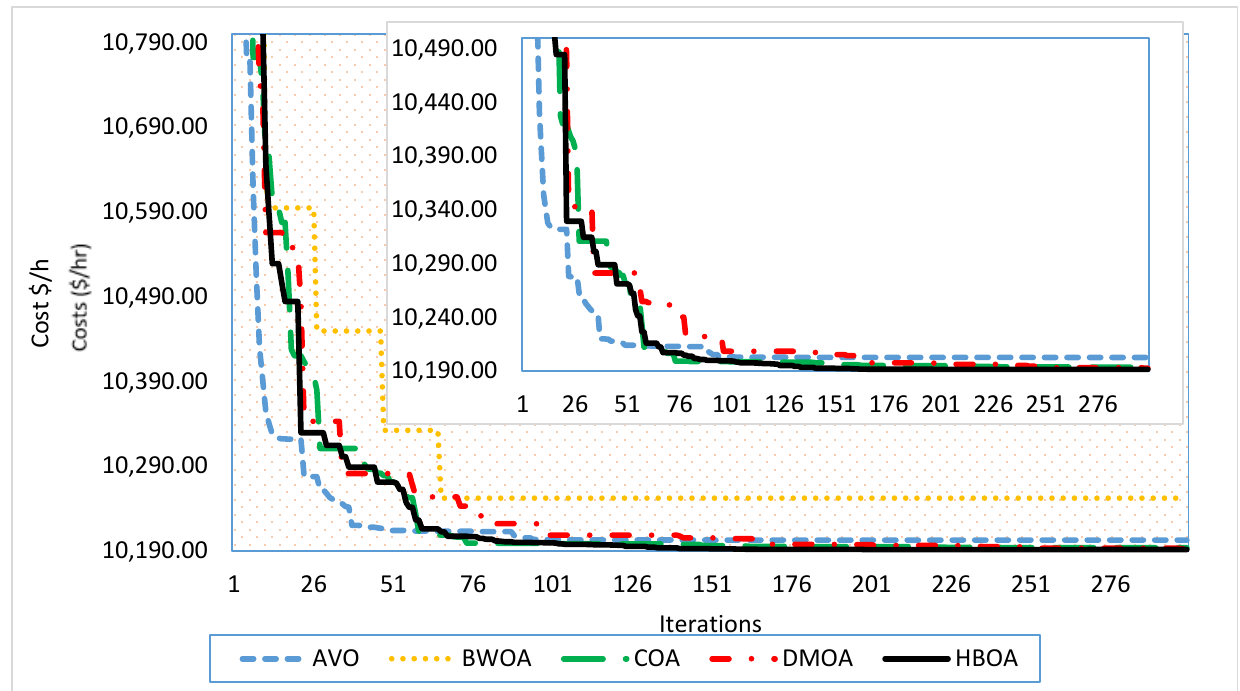
Figure 5. Convergence rates of the proposed HBOA and the AVO, DMOA, COA, and BWOA of Case 1 for the third loading.